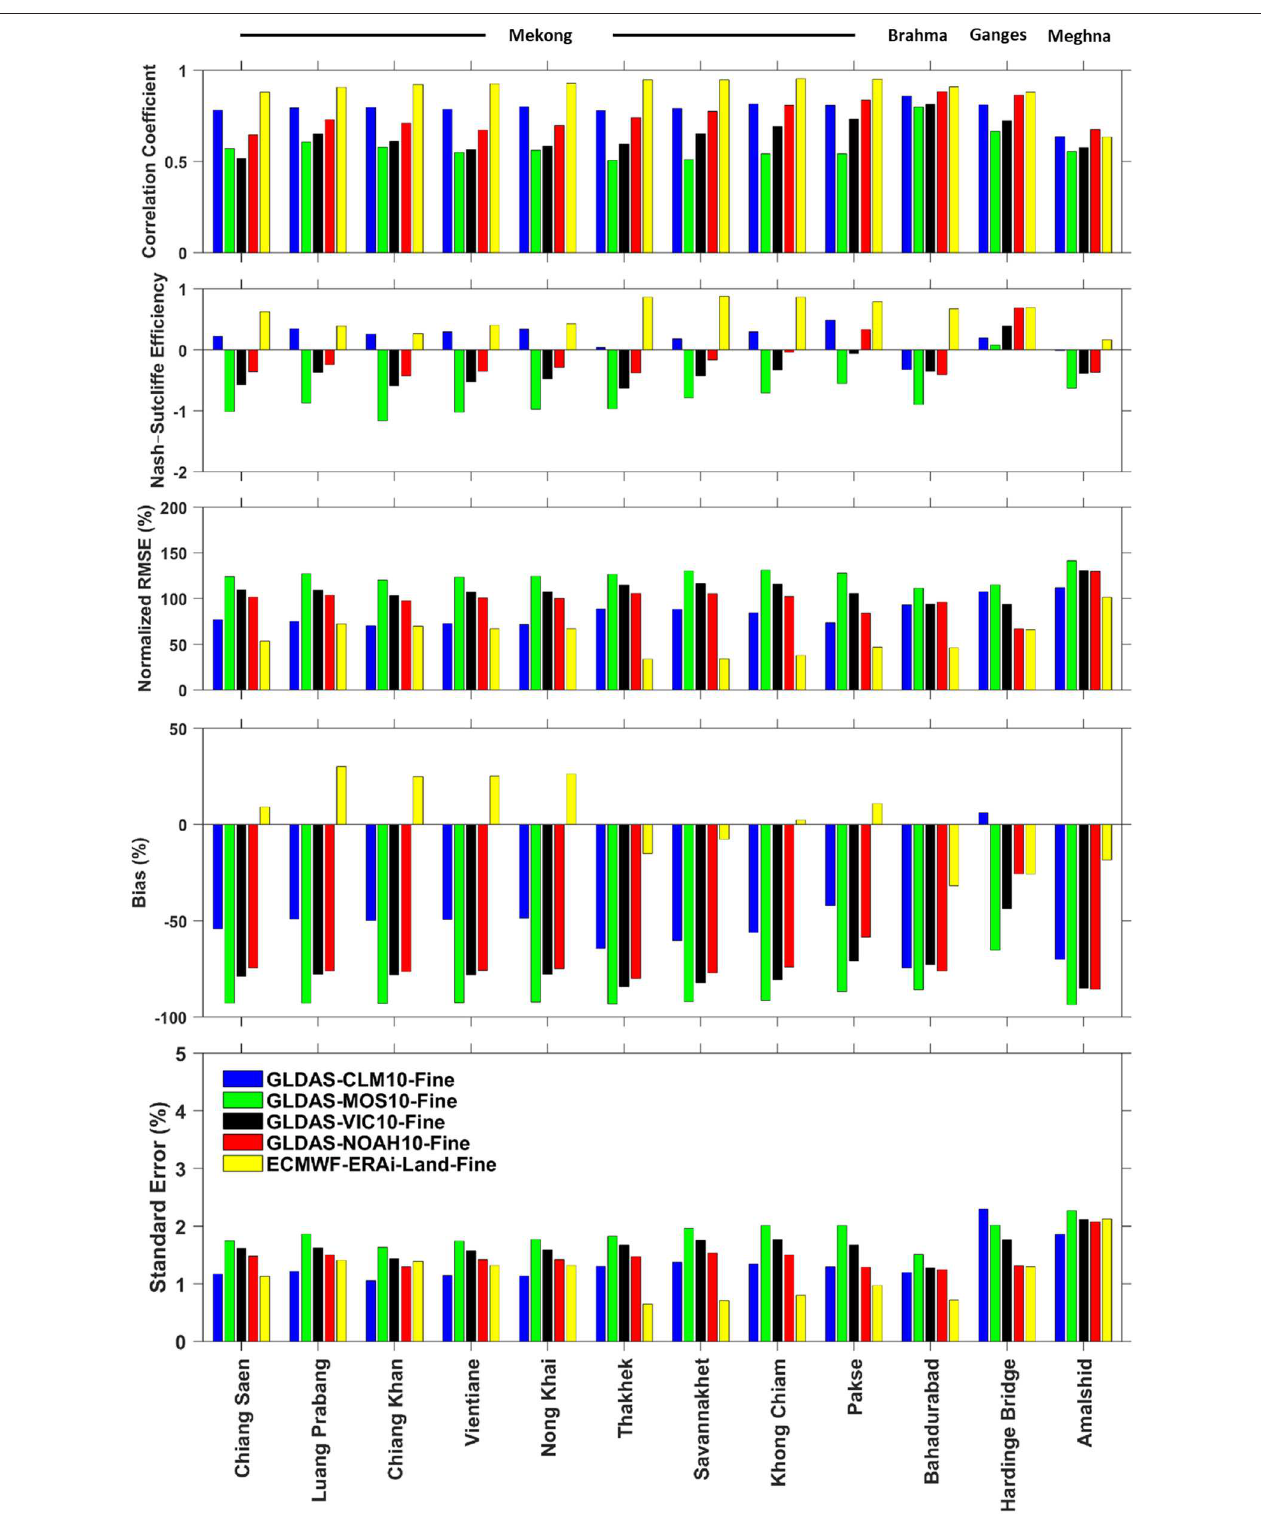
FIGURE 5 | Performance of simulated daily stream flow at different locations of the Mekong and GBM basin as a function of different LSMs. All the GLDAS LMSs in this experiment were forced with the same meteorological inputs. ERA-interim/Land from ECMWF (with different resolution and uses a different meteorological forcing) is shown here as a